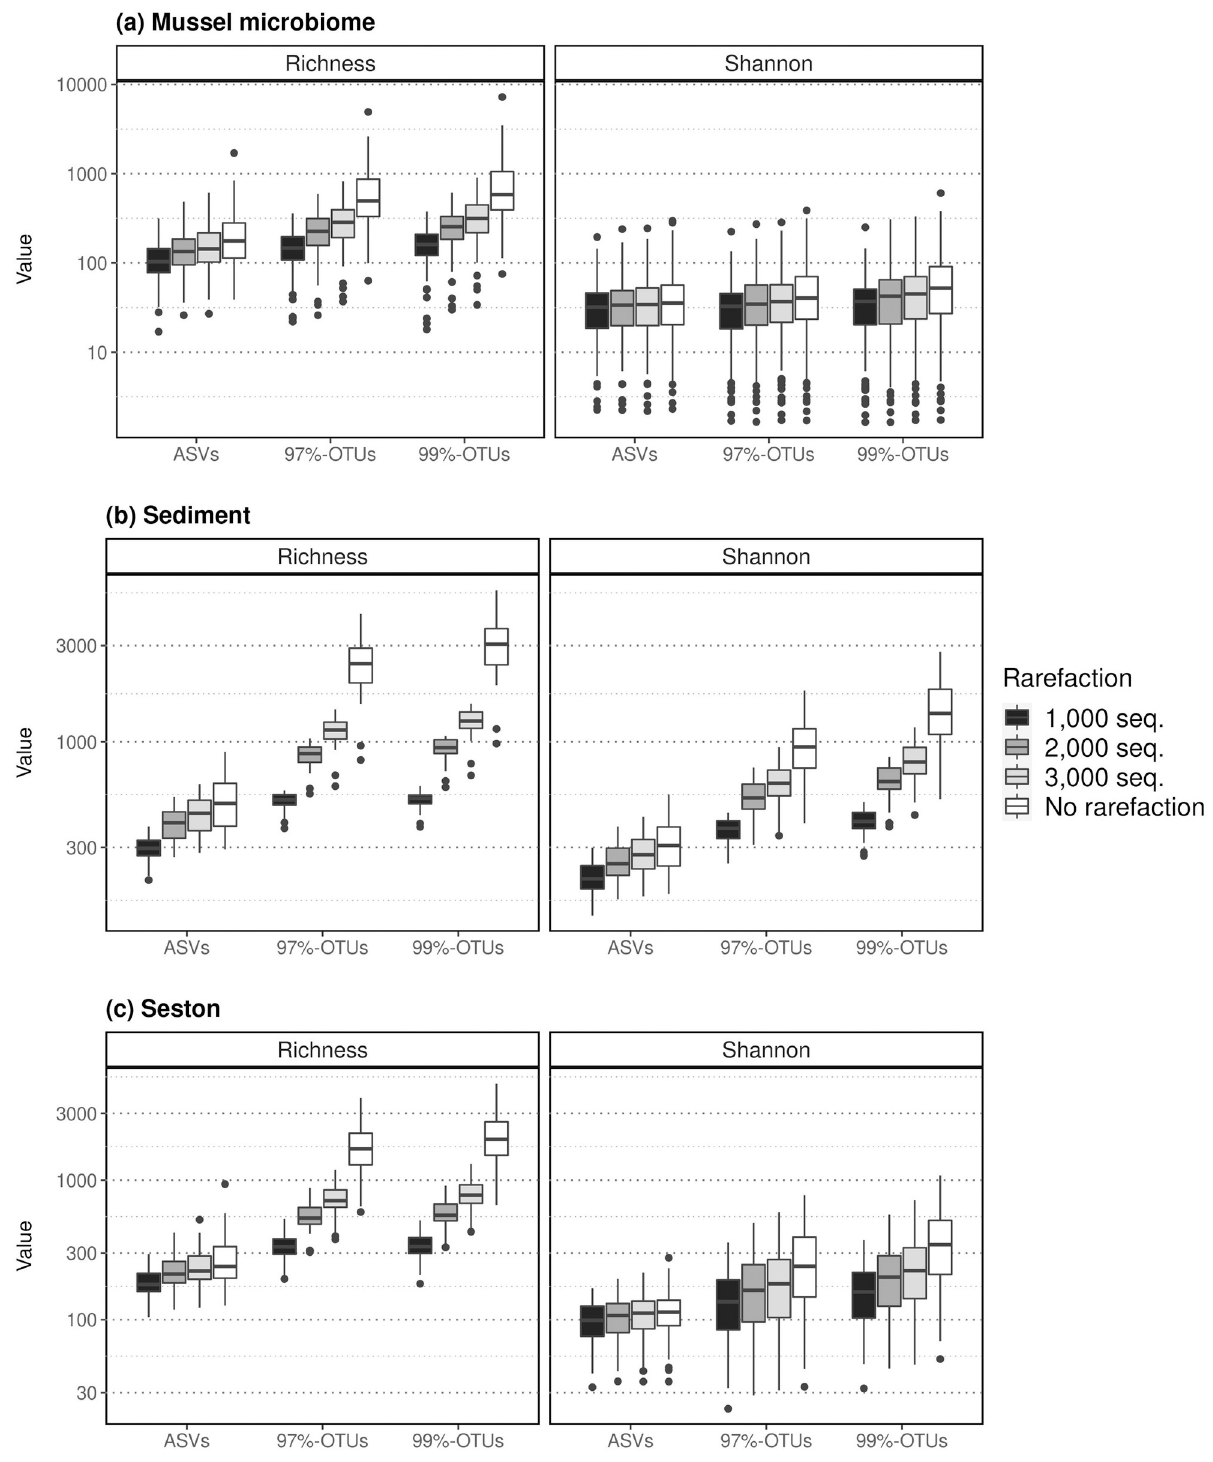
Fig 2. Effect of sequence processing methodology on alpha diversity metrics for microbiome analyses. Measure of taxonomic richness (expressed as the number of OTUs or ASVs and Shannon alpha diversity depending on the methodology used, namely ASV, 97%-OTU, and 99%-OTU, at three different levels of rarefaction (1,000; 2,000 and 3,000 sequences per sample) within each sample type studied (a-c). To ease the visualization of differences across methods and rarefaction levels, the y-axis of plots has been log transformed. The effect of methodological choices on other alpha diversity metrics is available in S3 Fig in S1